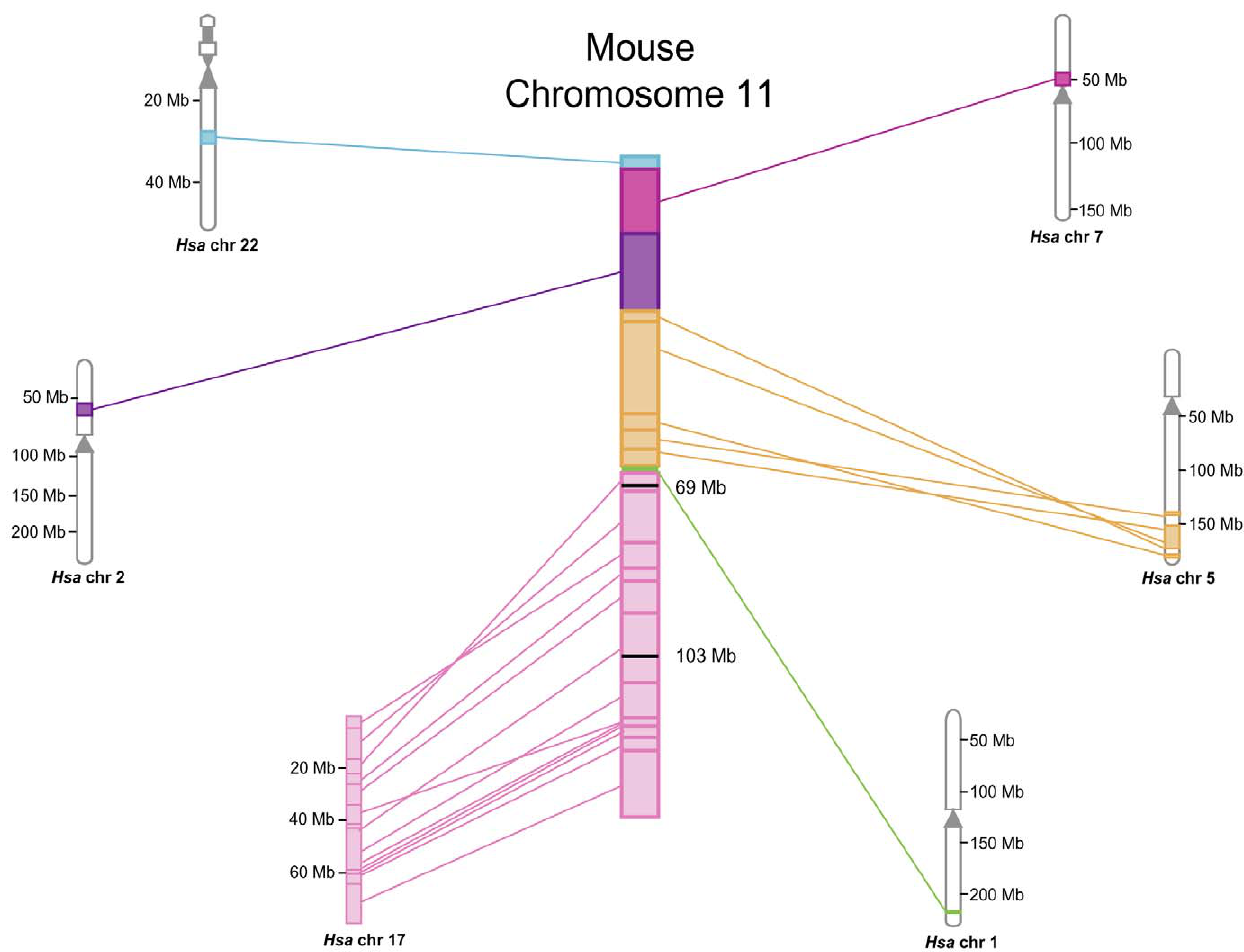
Figure 1. Synteny map of mouse Chromosome 11. Mouse Chromosome 11 is aligned with human chromosomes 22, 7, 2, 5, 1, and 17. Syntenic regions are represented in the same color and lines indicate breaks of synteny. The mouse Chromosome 11 ENU mutagenesis screen was targeted to the Trp53-Wnt3 (69 Mb–103.5 Mb) interval within the region most conserved with human Chromosome 17, indicated by the black lines.